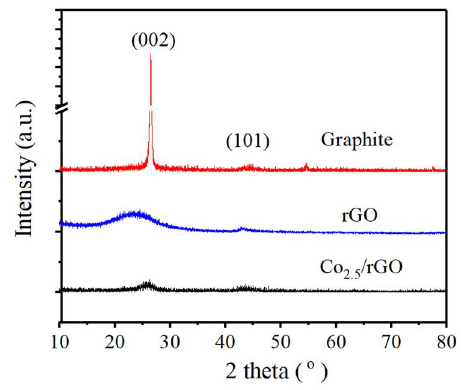
Figure 4. XRD patterns of graphite, rGO, and Co 2.5 /rGO.